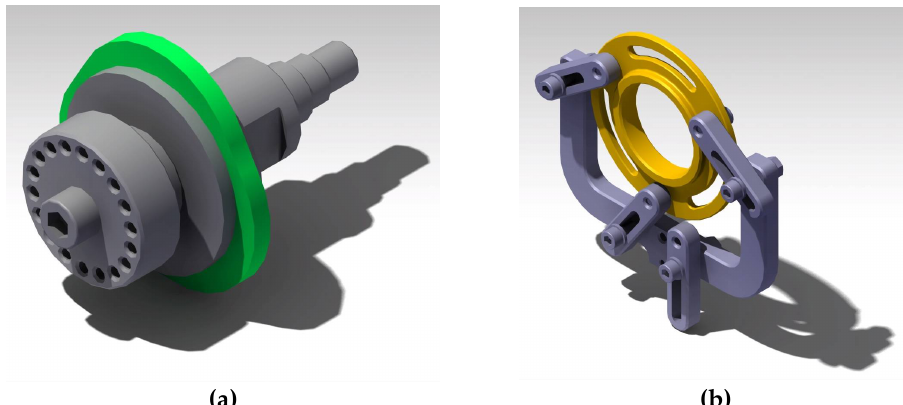
Figure 14. Rendering of the universal sensor adapter system. ( a ) Rotary part with an exemplary mounted resolver rotor (green part); ( b ) Stator adapter strap with an exemplary resolver stator, shown in yellow.